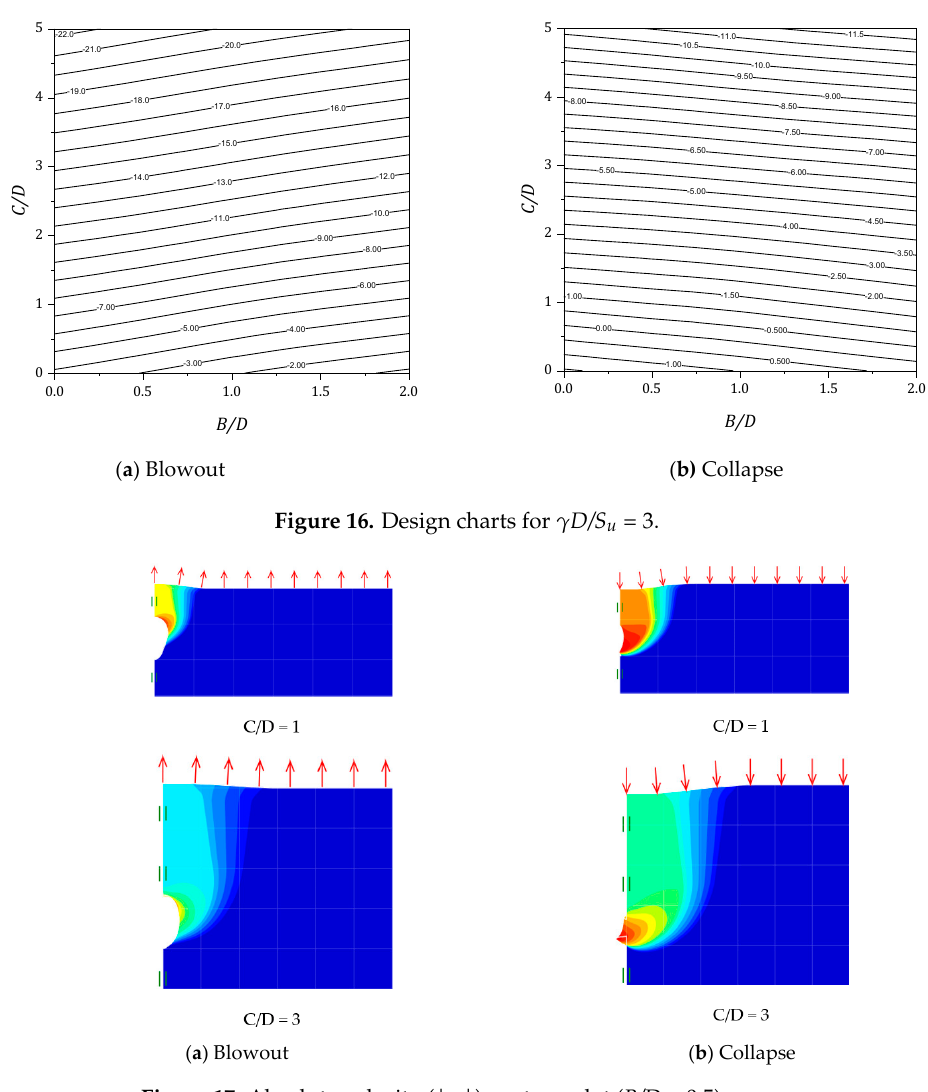
Figure 17. Absolute velocity (|u|) contour plot ( B/D = 0.5).